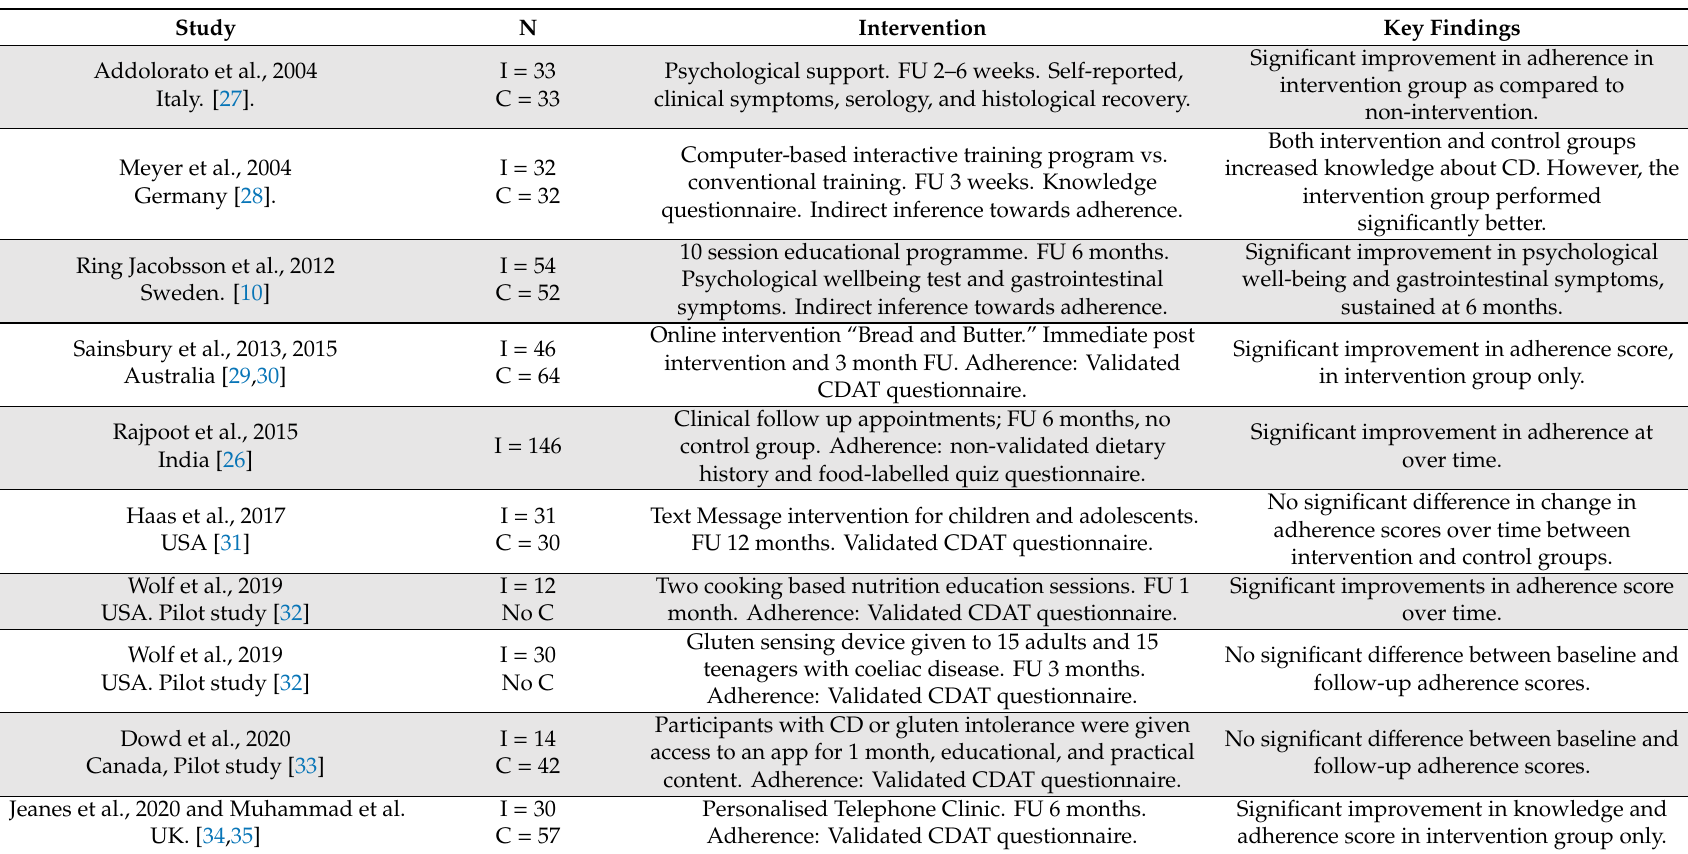
Table 1. Interventions to promote gluten free dietary adherence in patients with coeliac